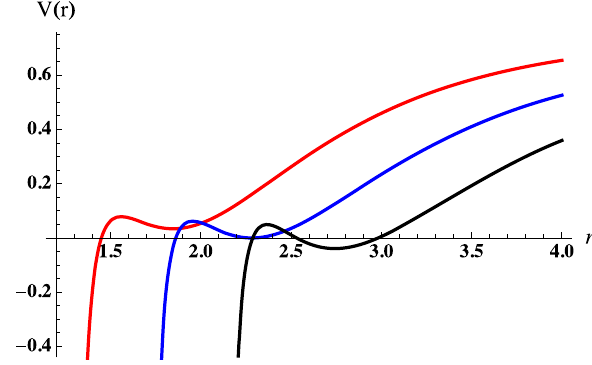
Fig. 9 V as one varies a , where a = 2 . 5 (black), 2 (blue), and 1 . 5 (red),